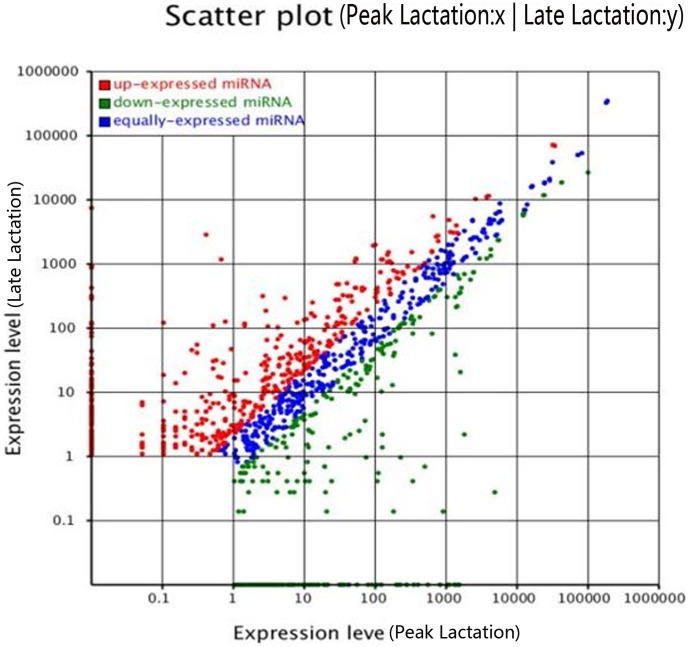
Comparison of expression levels of miRNAs in peak and late lactation.The X- and Y-axes show the expression levels of miRNAs in the two samples. The red points represent miRNAs with ratios >2; the blue points represent miRNAs with 1/2<ratios<2; the green points represent miRNAs with ratios <1/2. Ratios  = miRNA expression levels of late lactation/miRNAs expression levels of peak lactation.